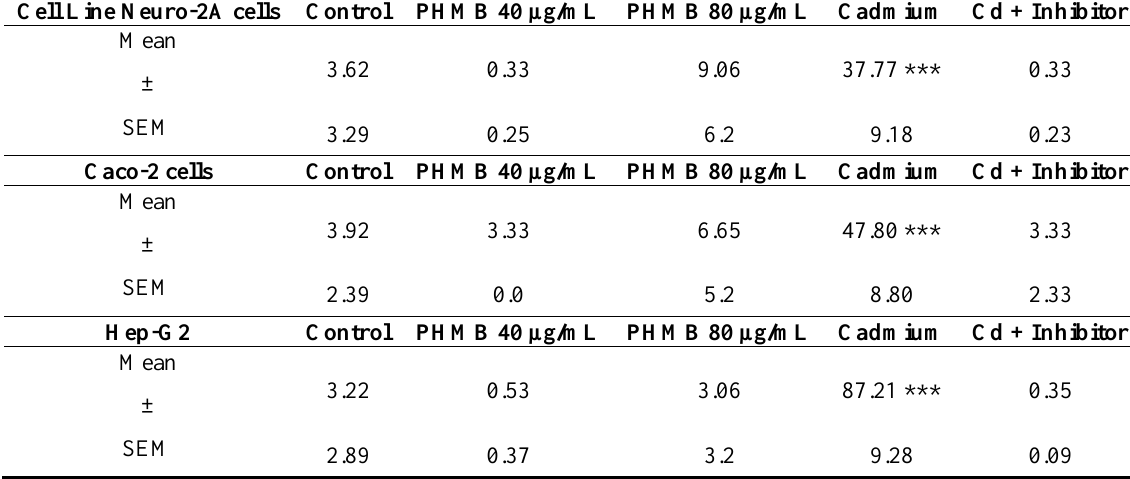
Table 7. Effect of PHMB on caspase-3 activation in Neuro-2A , Caco-2 and HepG2 cells . Cells are incubated with PHMB or cadmium (Cd 2+ ) (positive control) for 3 h and 24 h. Caspase-3 activity was measured using Promega CaspACE TM Assay System colorimetric kit. Results are expressed as pmol/µg of